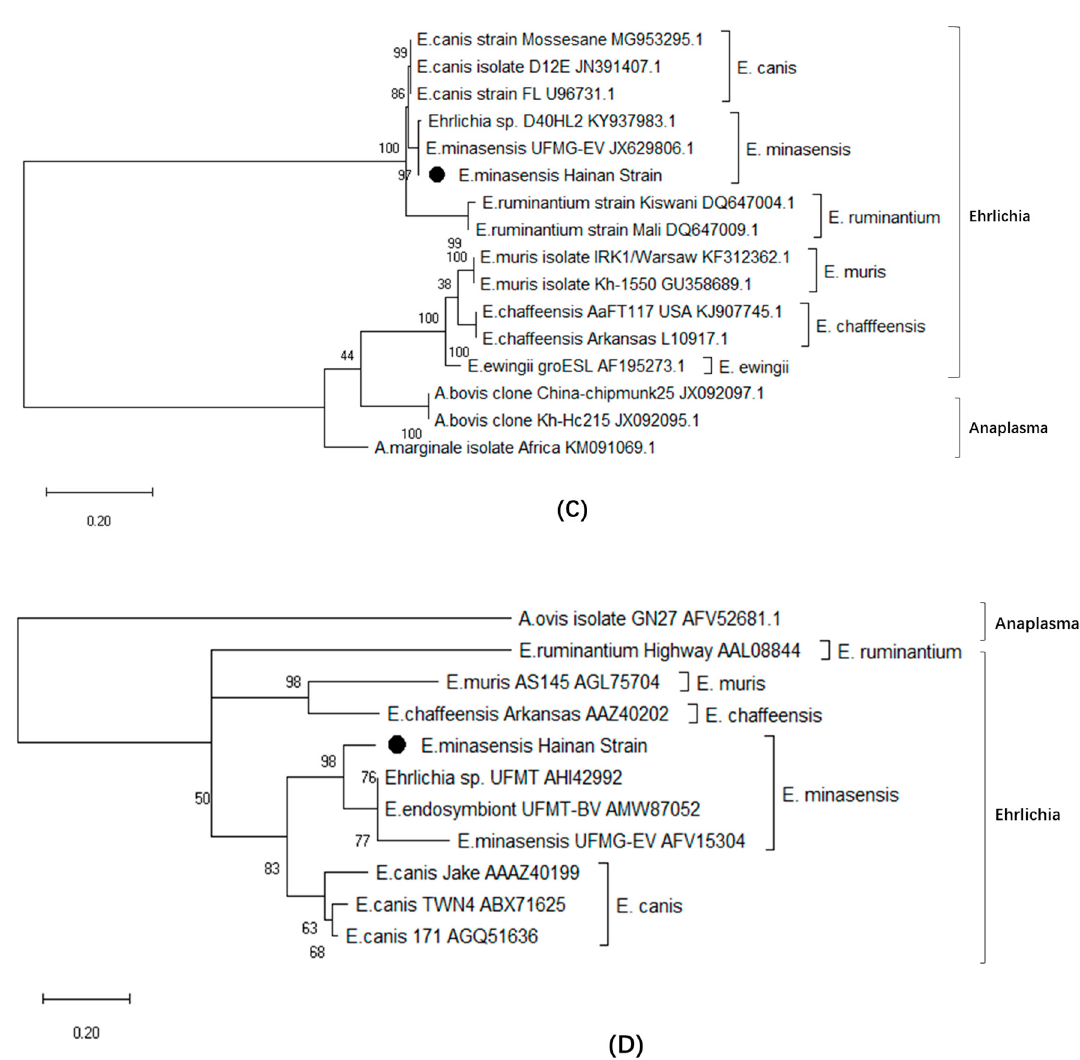
Figure 1. Phylogenetic tree based on the gene sequences of dsb ( A ), 16S rRNA ( B ), groEL ( C ), and amino acid sequences of trp36 ( D ) from geographically dispersed Ehrlichia minasensis and Ehrlichia canis strains, as inferred by the maximum-likelihood method using other species of Ehrlichia as a genus outgroup and other strains of Anaplasma as a genuine outgroup. The tree with the highest log